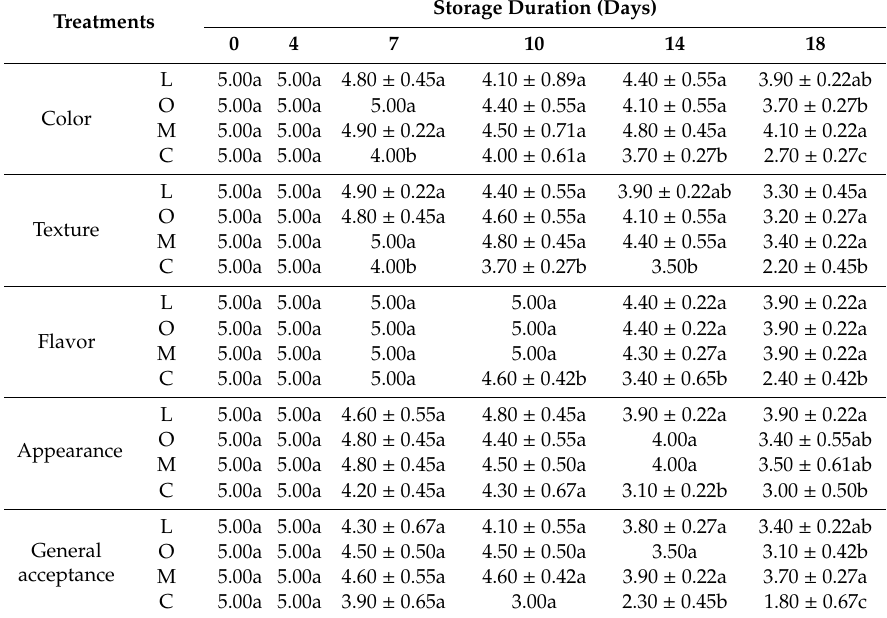
Table 3. Effect of different essential oil emulsions (L = lemon, O = orange, and M = mandarin essential oil) on color, texture, appearance of strawberry fruits stored at 2 °C for 18 days. Different letters indicates significant difference between treated and control fruits at each storage period (Duncan’s of 95%).